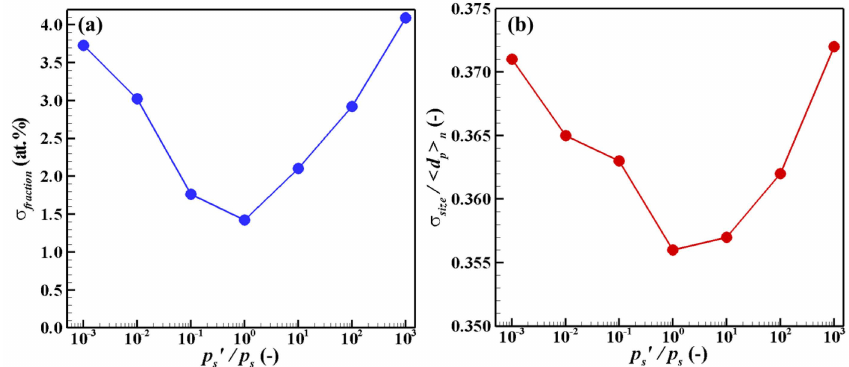
Figure 8. Effects of saturation pressure difference on dispersion of ( a ) fraction and ( b )